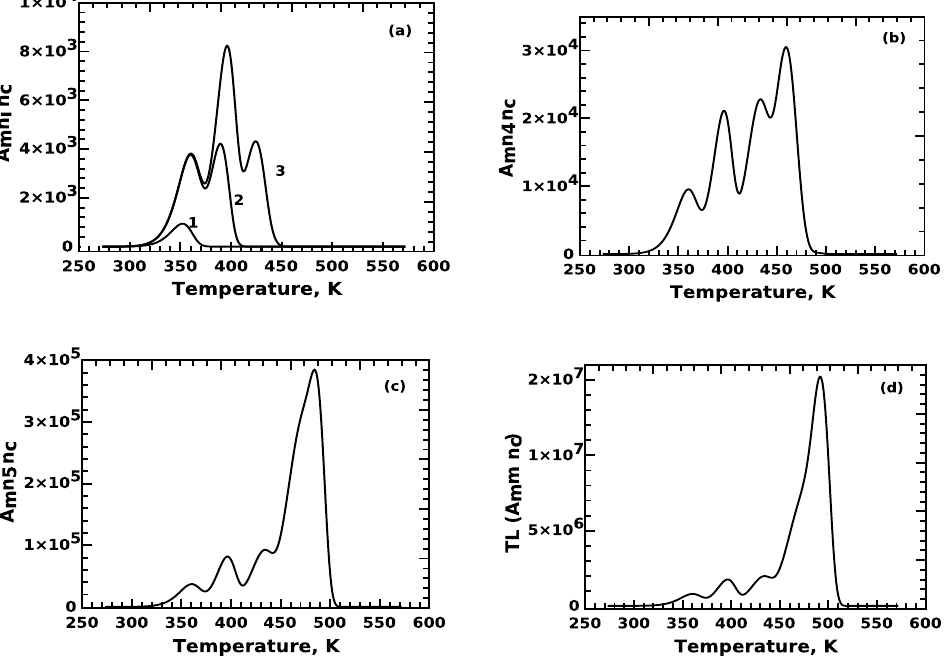
Figure 3. TL peak shape in the case of REFERENCE-01 glow curve, as evaluated from the numerical solutions of the model in Section 2.1. ( a ) Shapes of peaks 1, 2 and 3, ( b ) shape of peak 4, ( c ) shape of peak (5) and ( d ) total glow curve shape. It is obvious that except peak 1, all other peaks, although they must be of single-peak shape, look composite, because the electron distribution within the conduction band contributes to their numerical